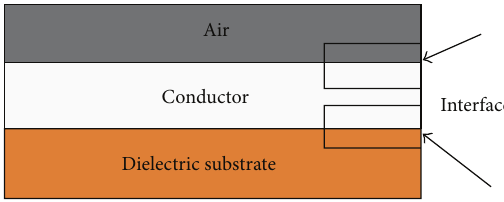
Figure 2: Resonator material Laris